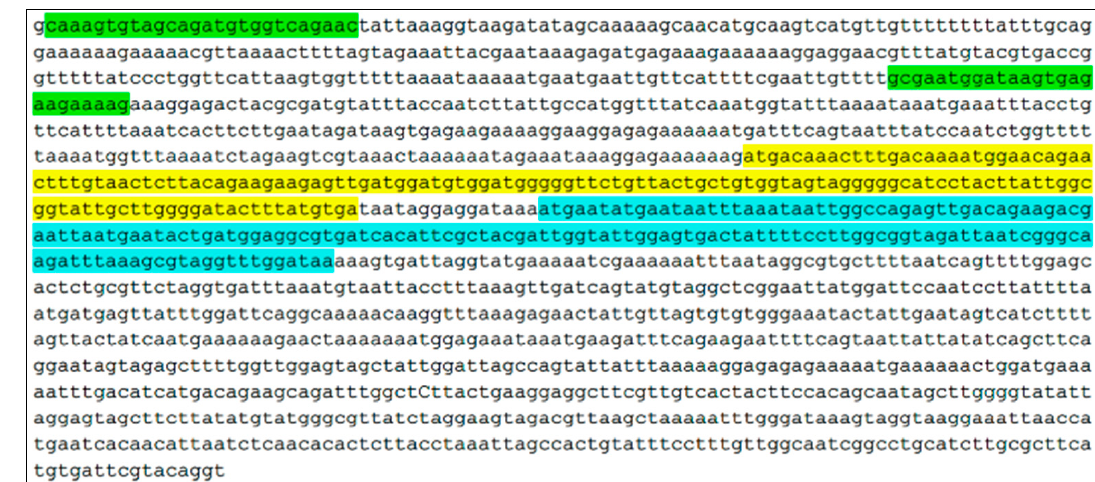
Figure 1. DNA sequence of S. downii indicating the position of the primers (marked in green) and the two open reading frames of the encoded bacteriocins in this fragment (marked in blue and